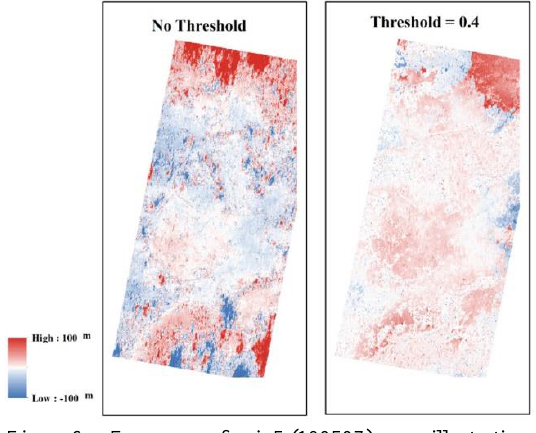
Figure 6. Error map of pair 5 (190507) as an illustration.